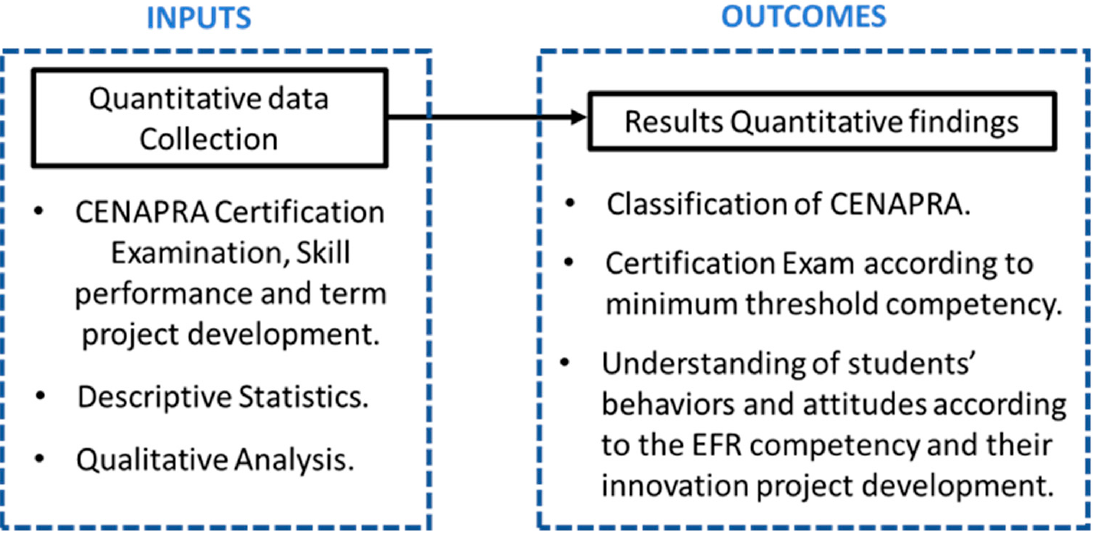
Table 1. Student participation and certifications by CONAPRA from 2015 to